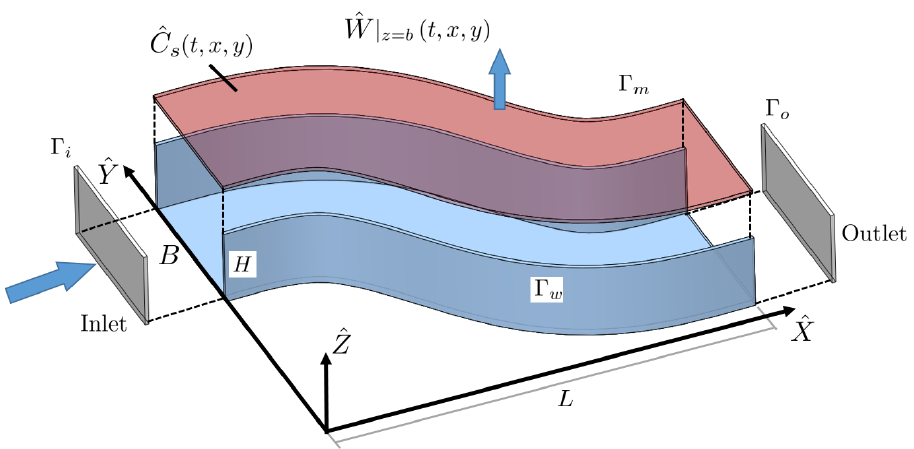
Figure 1. Three-dimensional sketch of the domain, with the definition of wall and membrane